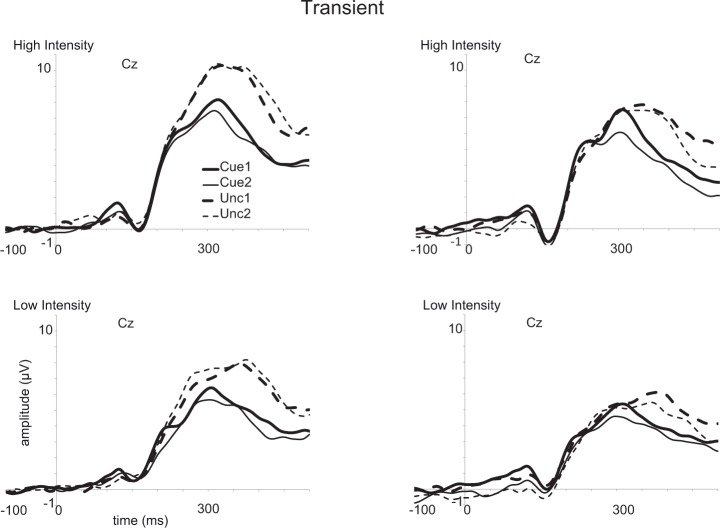
Event-related potentials (ERPs) evoked by the intracutaneous stimuli at the vertex (Cz).Results are shown for the transient spatial attention condition. For further details, see Fig 10.